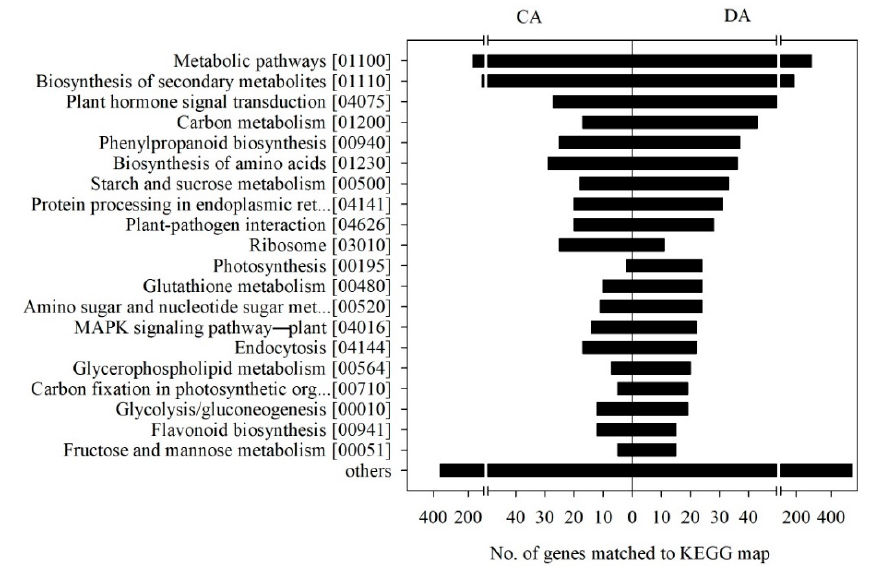
Figure 4. Biochemical pathways with their identification numbers, based on the KEGG database categories, enriched in the DEGs with a |fold change| > 2 ( p < 0.05) in the ‘Soomee’ peach tree shoots during cold acclimation (CA) and deacclimation (DA). Fold changes were determined based on the FPKM values at late CA and late DA as compared to those at early and late CA, respectively. Table 2. Correlations of the cold hardiness (LT 50 ), and relative expression (RE) and log 2 (FPKM + 1) values of the selected DEGs during cold acclimation (CA), from early to late CA, and deacclimation (DA), from late CA to late DA, in the ‘Soomee’ peach tree shoots for the validation of the in silico data by qPCR.